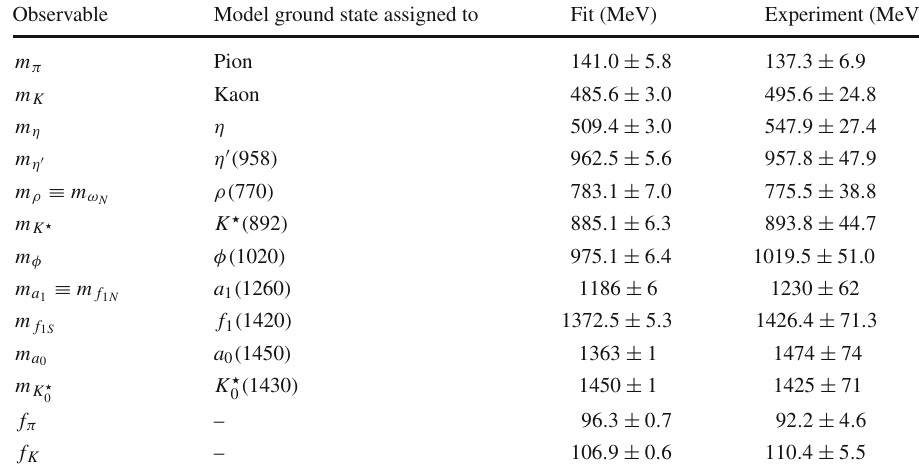
Table 1 Best-fit results for masses of ground-state mesons and pseudoscalar decay